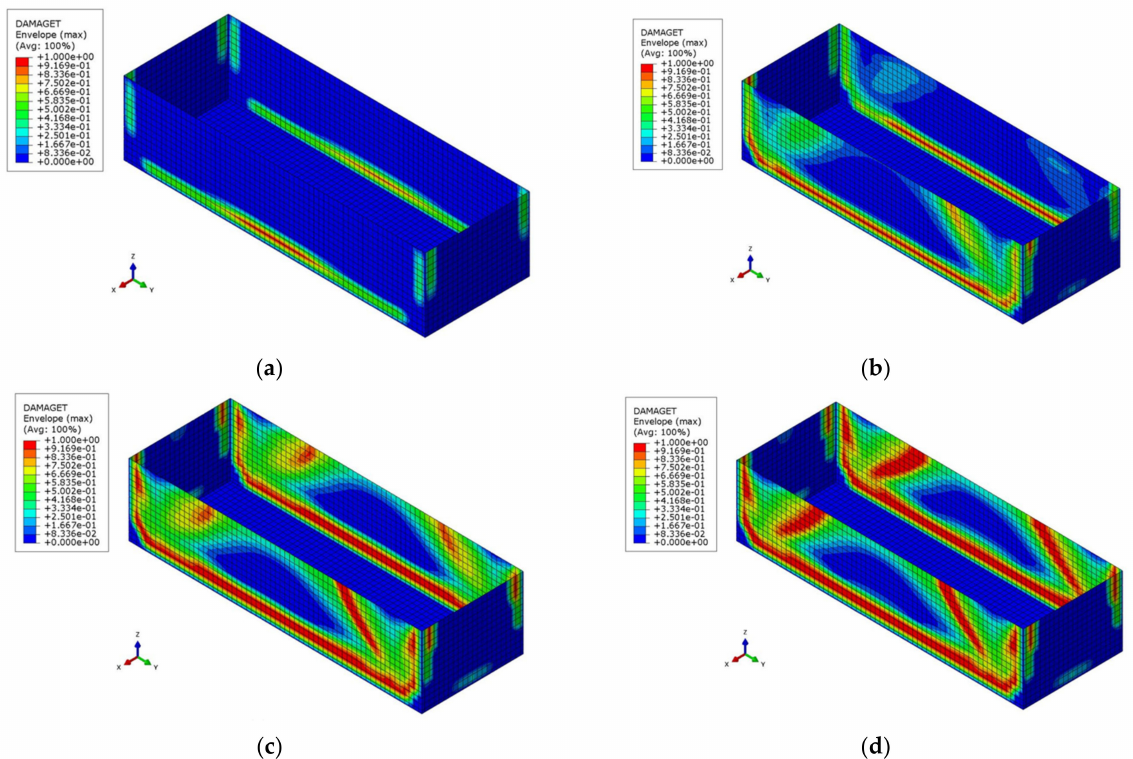
Figure 17. Tensile damage variable d t when the incident angle of the input ground motion is 100 ◦ : ( a ) 1.30 s; ( b ) 2.15 s; ( c ) 8.71 s; ( d ) 25.53